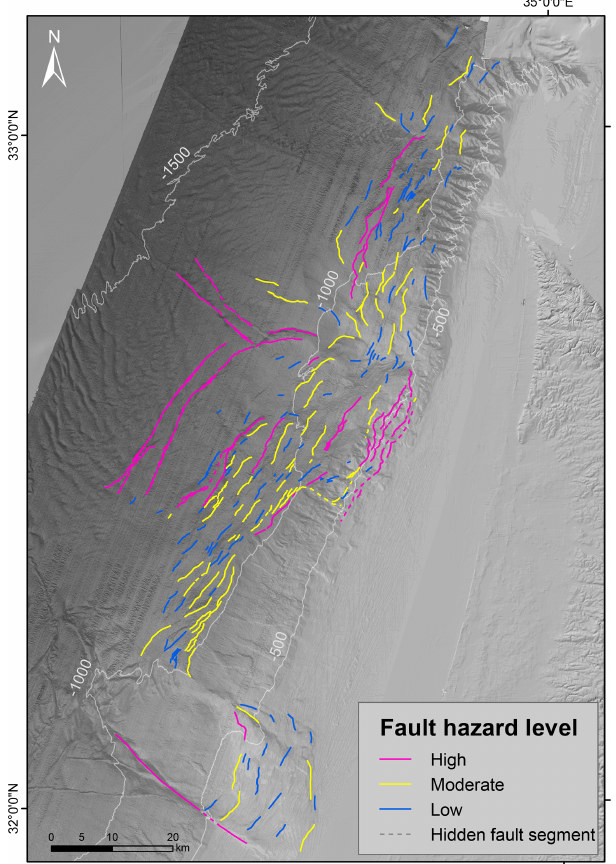
Figure 13. Final simplified fault displacement hazard map classi- fied into three hazard levels according to a combination of the two criteria presented in Fig. 12 (i.e., vertical fault displacement and size). The combination is conservative; i.e., a high level is assigned to a fault segment, which either is characterized by high vertical dis- placement or belongs to a big fault; low means low vertical displace- ment and small size; moderate are all the rest. Bathymetry from Ti- bor et al.